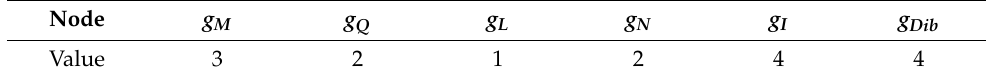
Table 9. Relative cost coefficient values in Topology